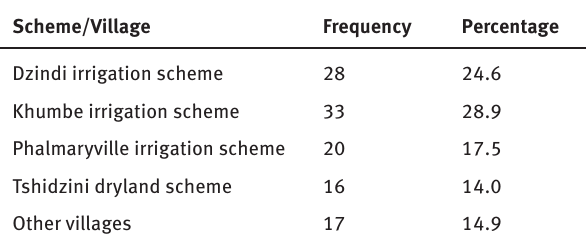
Table 1: Distribution of farmers according to Schemes and Villages in Vhembe district